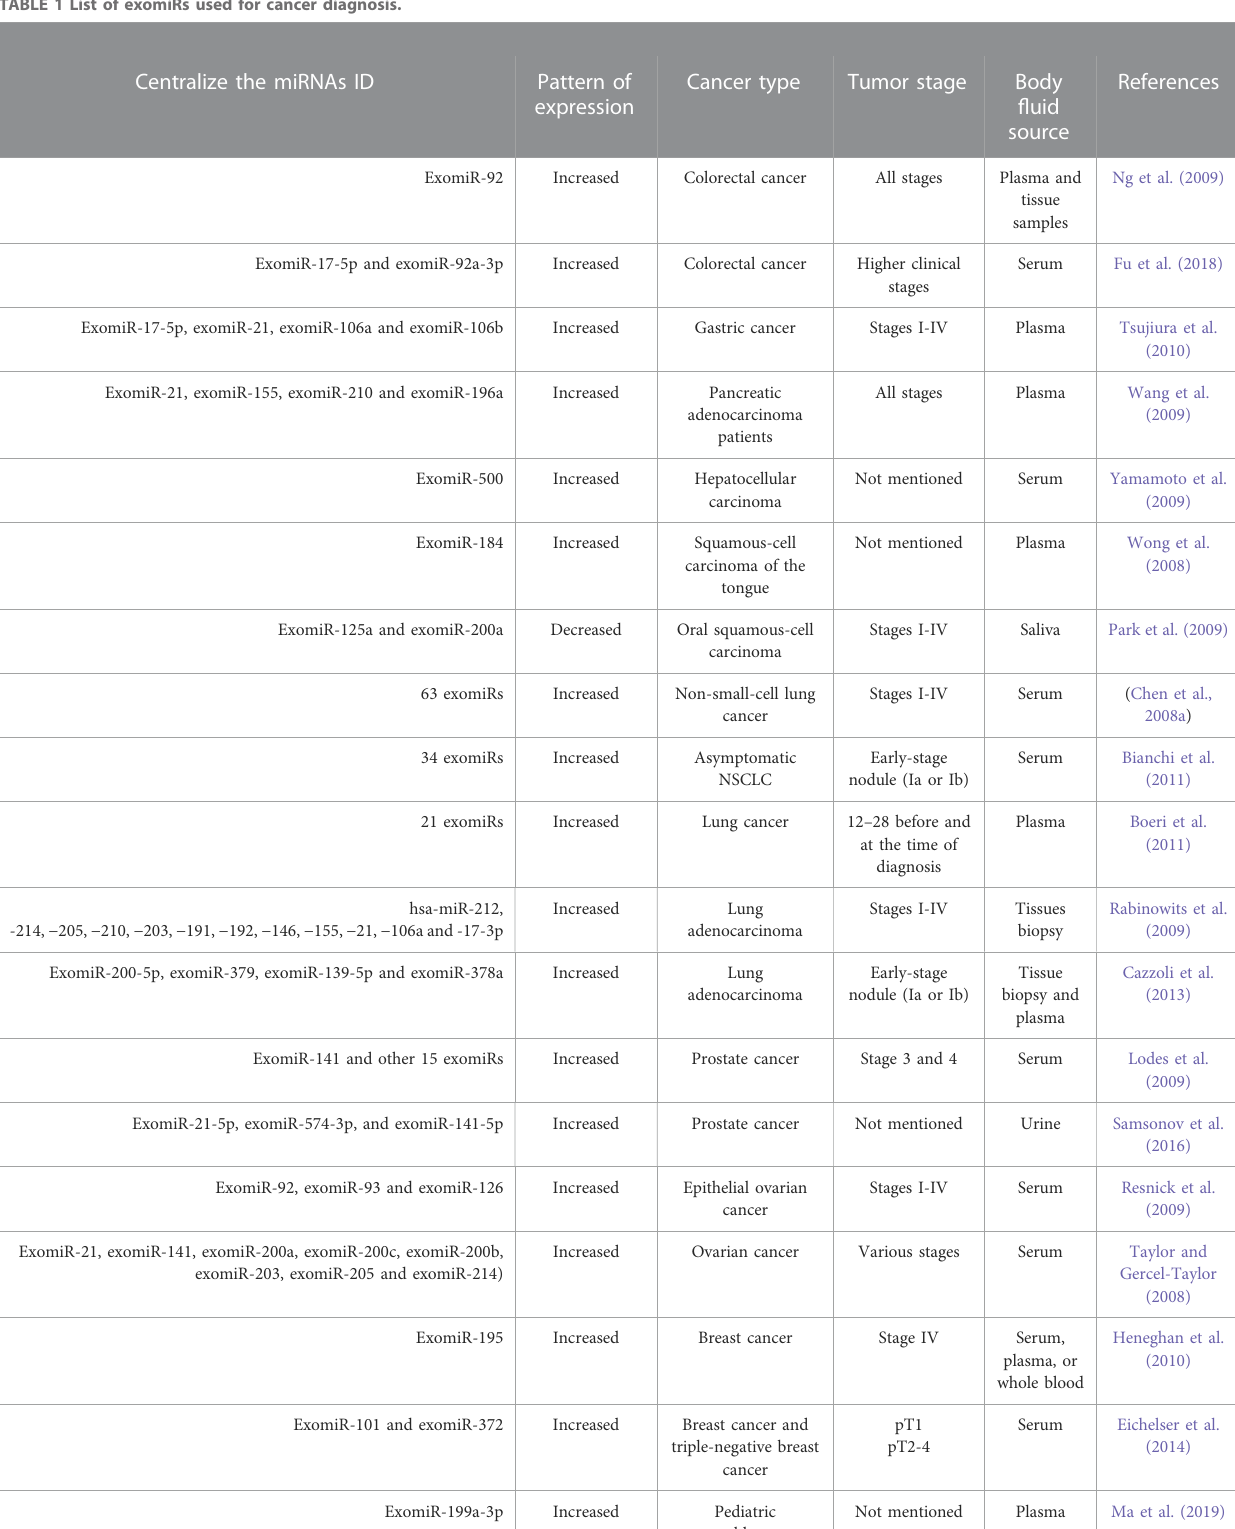
TABLE 1 List of exomiRs used for cancer